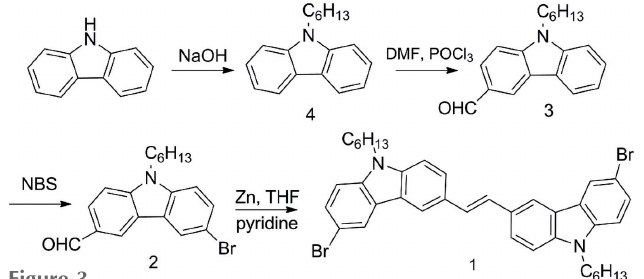
Figure 3 Reaction